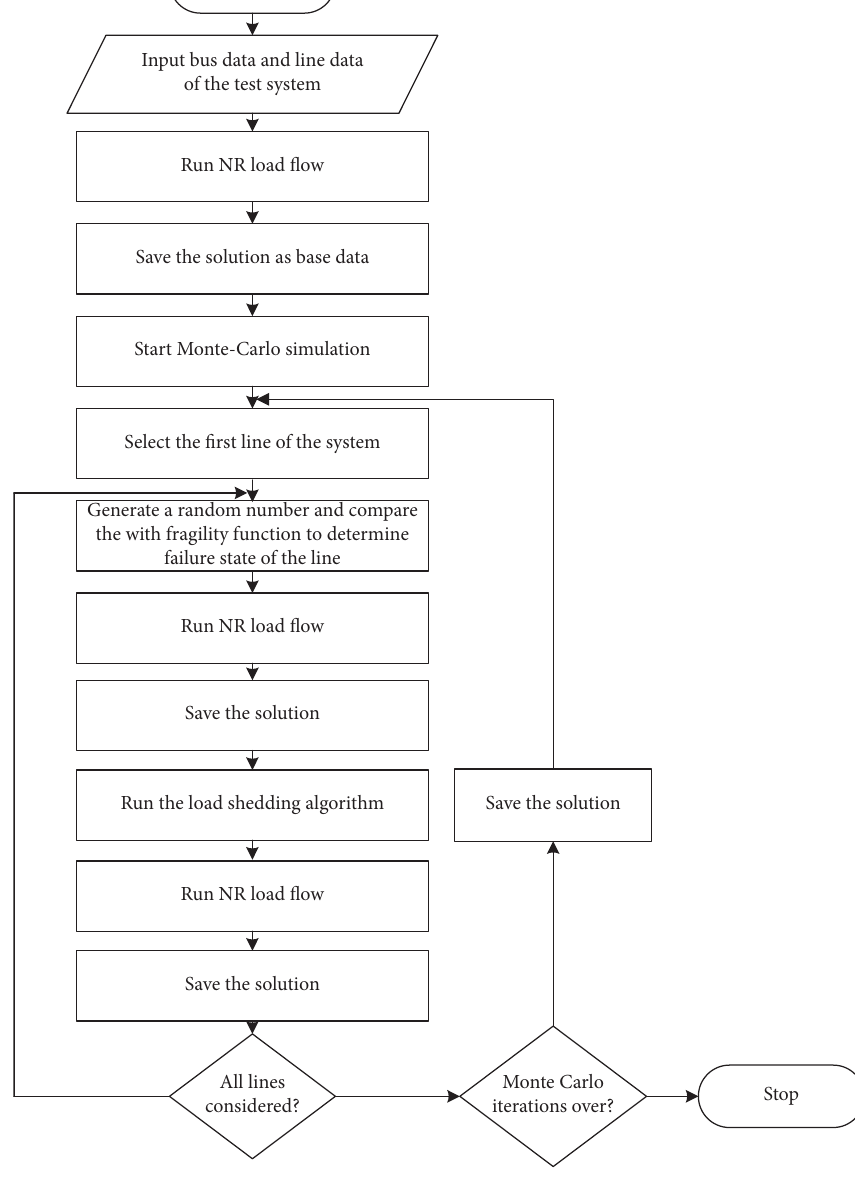
Figure 5: Flowchart representation of the